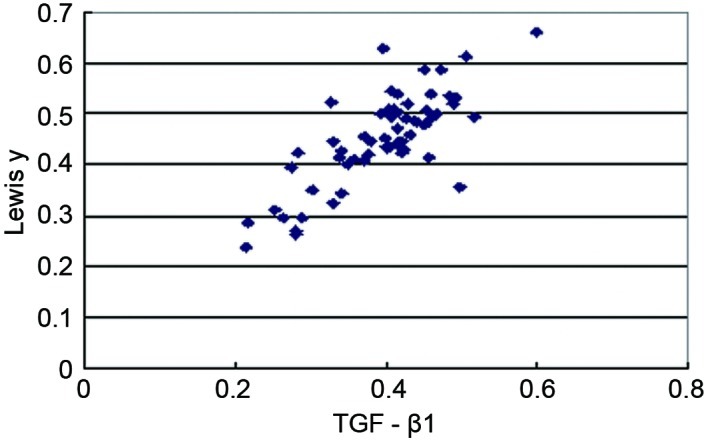
The scatterplot of mean optical density (MOD) value of Lewis y and TGF-β1 in ovarian cancer.